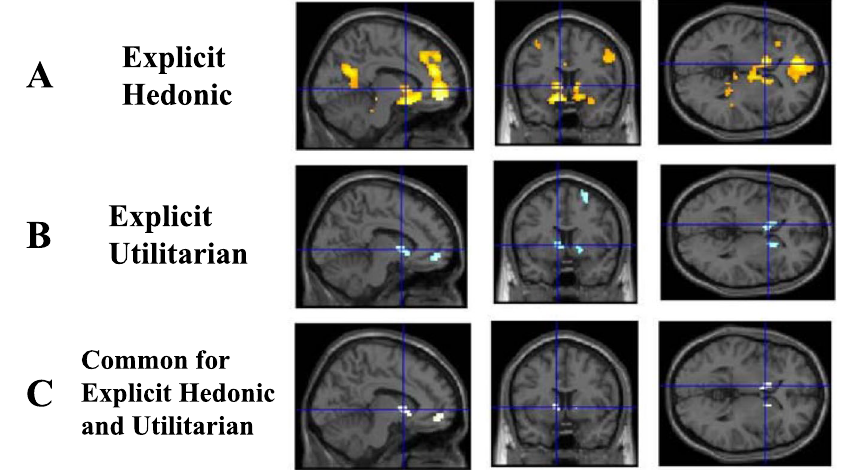
Figure 2. Brain regions correlated with hedonic and utilitarian values during purchasing decisions. ( A ) Voxels in pale pink correlated with hedonic values, ( B ) voxels in blue correlated with utilitarian values, and ( C ) the conjunction of hedonic and utilitarian values shown in yellow. Sagittal, coronal, and axial sections showing the peak activation of vmPFC (x = − 6, y = 47, z = − 8), right VS (x = 9, y = 14, z = − 5), and left VS (x = − 9, y = 8, z = 1), respectively. The peak activations derived from the conjunction analysis of hedonic and utilitarian values during purchasing decisions. The data are presented in figures at a threshold of p < 0.001, uncorrected for illustrative purposes only. Coordinates are reported in the stereotaxic space of the MNI. Abbreviations: vmPFC (ventromedial prefrontal cortex); VS (ventral striatum); MNI (Montreal Neurological Institute).